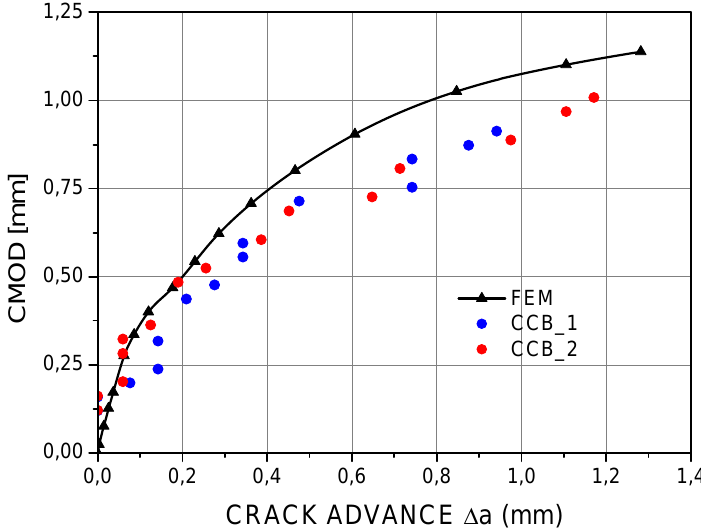
Figure 10: Comparison of predicted and measured CMOD vs crack advance